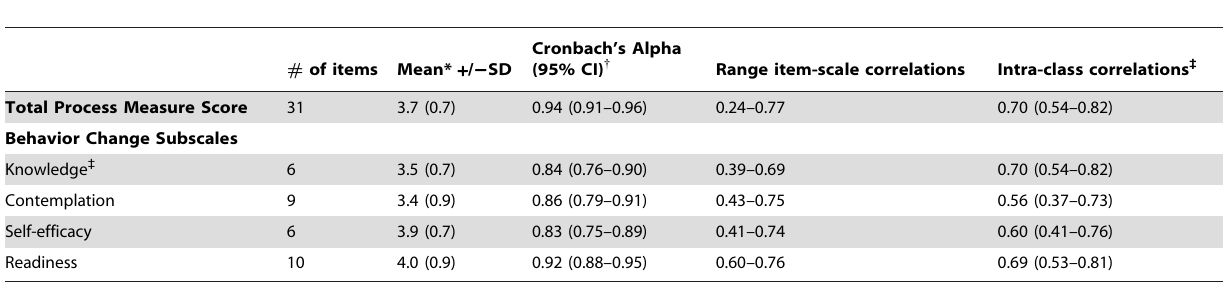
Table 4. Advance Care Planning Engagement Survey – Process Measures: Reliability, Item-Scale Correlations, & Descriptive